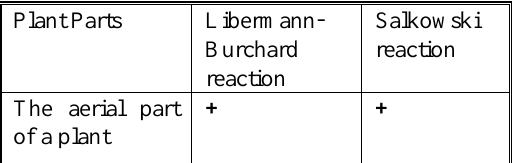
Table 1. Result of the chemical tests for hexane